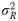
A: Generative model involved during choice between two options (characterized by a single attribute), one associated with high reward (RH = 10) and the other with low reward (RL = 6). B: Proportion of choices of the better over choices of the worse option predicted by BCV (P[RH|RH,RL]/P[RL|RH,RL], as a function of prior expectation μC and reward uncertainty σR2 (100000 trials are simulated for each condition; σC2 = 1 for simulations). BCV assumes a softmax choice rule (with inverse temperature parameter equal to one for all simulations) and an equal probability for each option of being considered during the first inference step. This shows bell-shape functions where peaks correspond to a prior mean expectation of (RH–RL)/2 and where the reward uncertainty σR2 determines the width of the function (smaller uncertainties are connected with narrower functions).